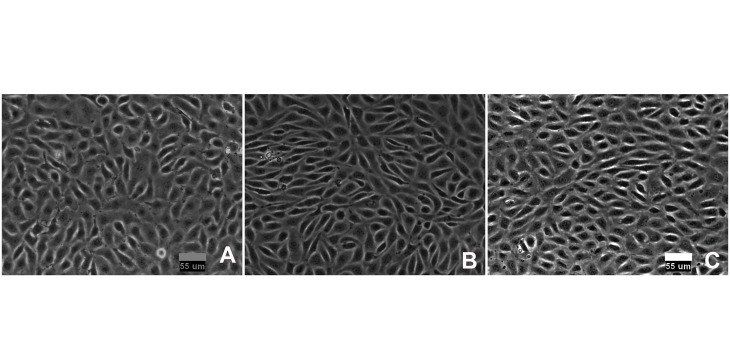
Endothelial cells seeded on the inner surface of silicone substrates.(A) Control conditions. ECs formed a confluent monolayer that has a cobblestone appearance. (B) After 7-h-exposure to WSS (10±10 dynes/cm2) and CS (4 ± 4%) at SPA = 0° and (C) SPA = -180°. ECs remained confluent but showed subtle morphological changes. Flow is from left to right; strain is perpendicular to flow.